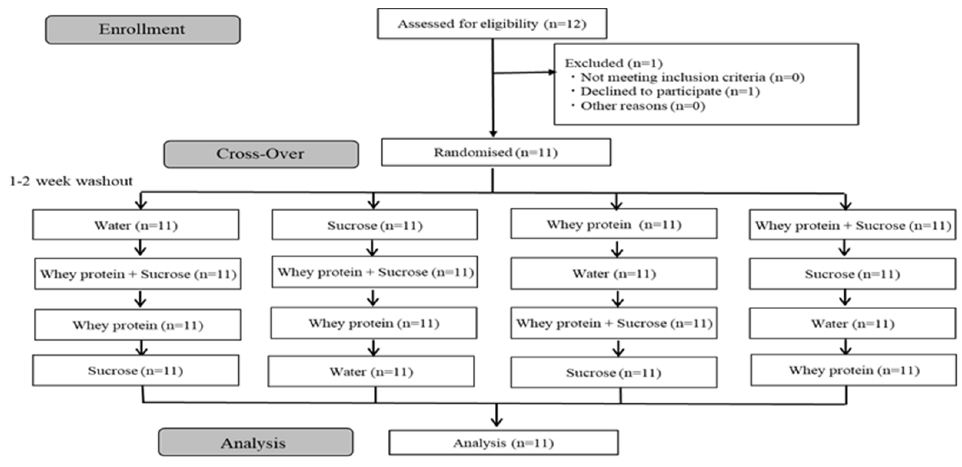
Figure 4. Study flow chart .